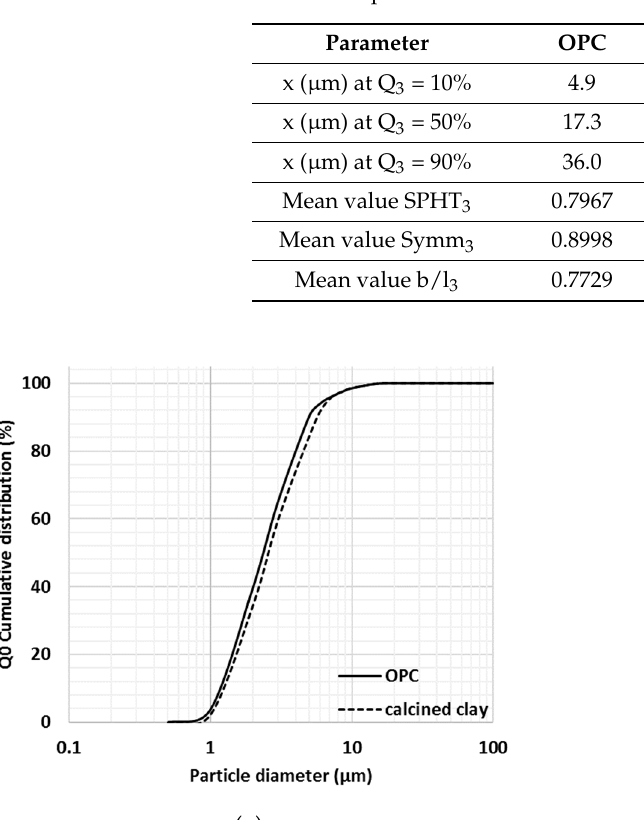
Table 3. Properties of the selected SCMs and OPC.